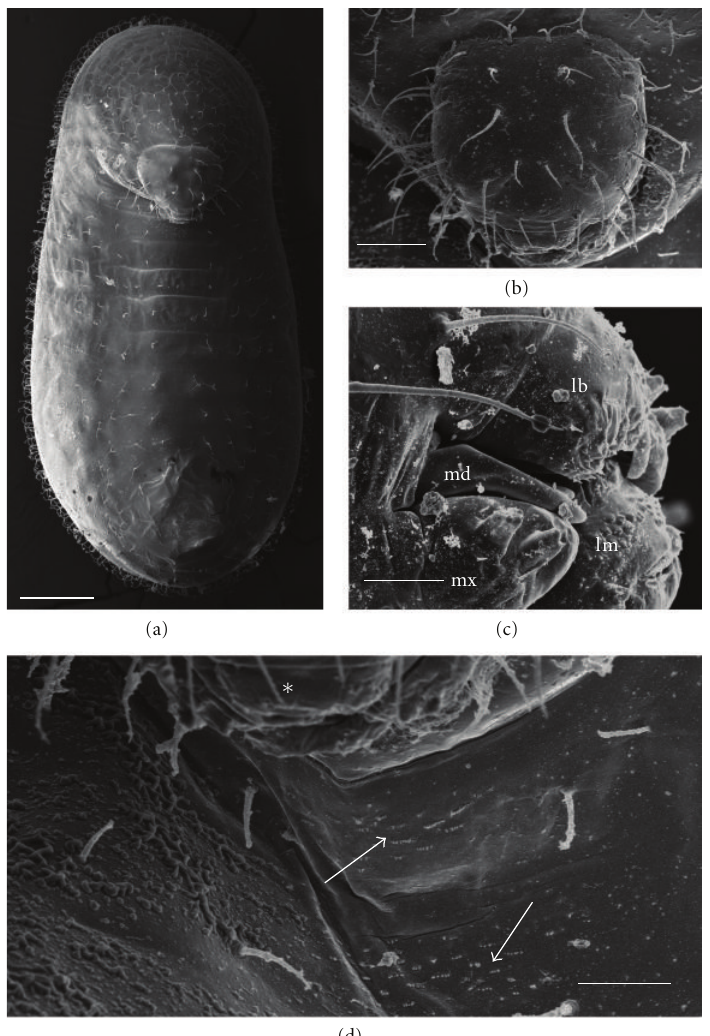
Figure 5: Last instar larva of Solenopsis saevissima gyne. (a) Body in frontal view. (b) Head capsule in full frontal view. (c) Mouthparts in oblique view; lb: labrum; md: mandibule; mx: maxilla; lm: labium. (d) Food basket area, asterisk: lower mouthparts; arrows: rows of spinules. Respective sizes of scale bars ( µ m): 400, 100, 50, and